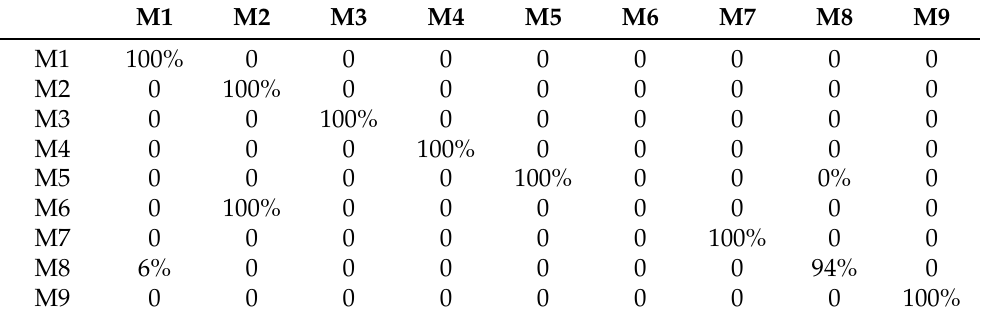
Table 4. Confusion matrix for cGAN.